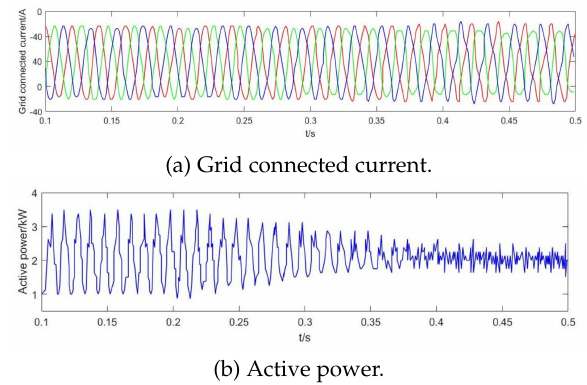
Fig. 10. Simulation results of coordinated control scheme in reference